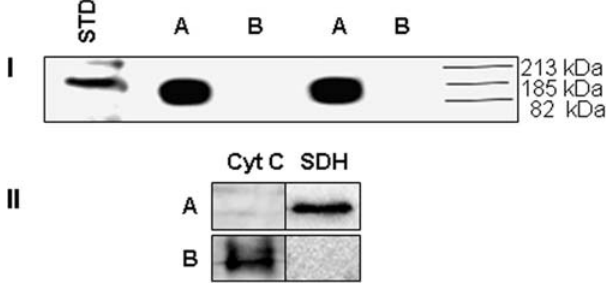
Figure 10. Lactate dehydrogenase localization in an astrocytic cell line. A) Hoechst stain for the nucleus. B) Rhodamine B stain utilized for mitochondrial localization. C) FITC tagged secondary for anti-LDH. D) Merged image of Hoechst, Rhodamine B, and FITC. Note: Yellow spots are indicative of LDH associated with the mitochondria.